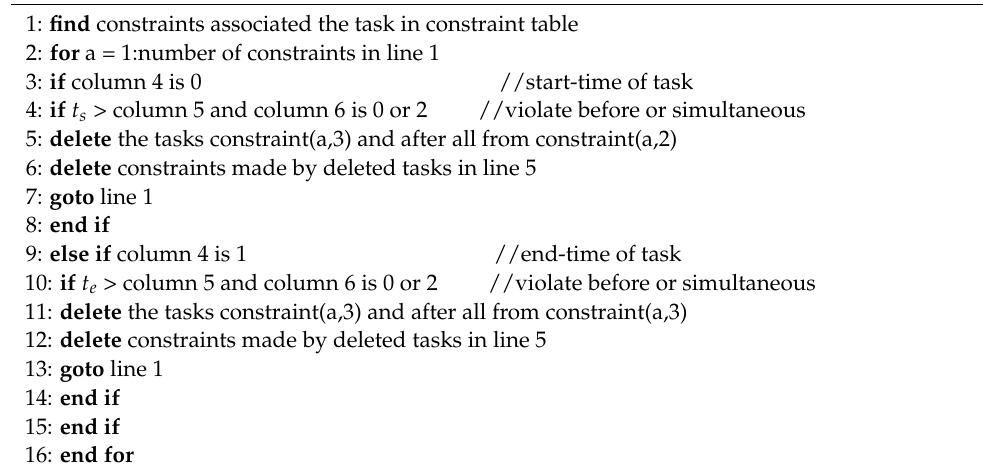
Algorithm 8 Centralized TACTAR: line 15 of Algorithm